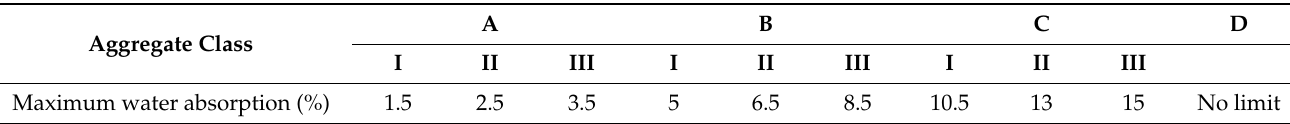
Table 5. Physical property requirements for the proposed classes